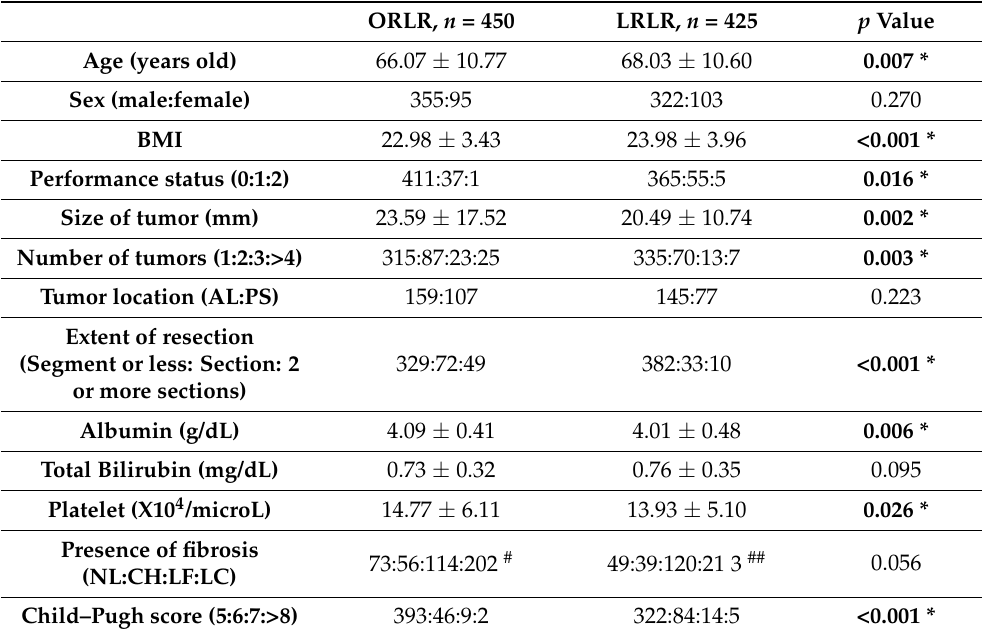
Table 1. Background factors of all patients ( n = 875) with ORLR or LRLR before RLR. ORLR, n = 450 LRLR, n =